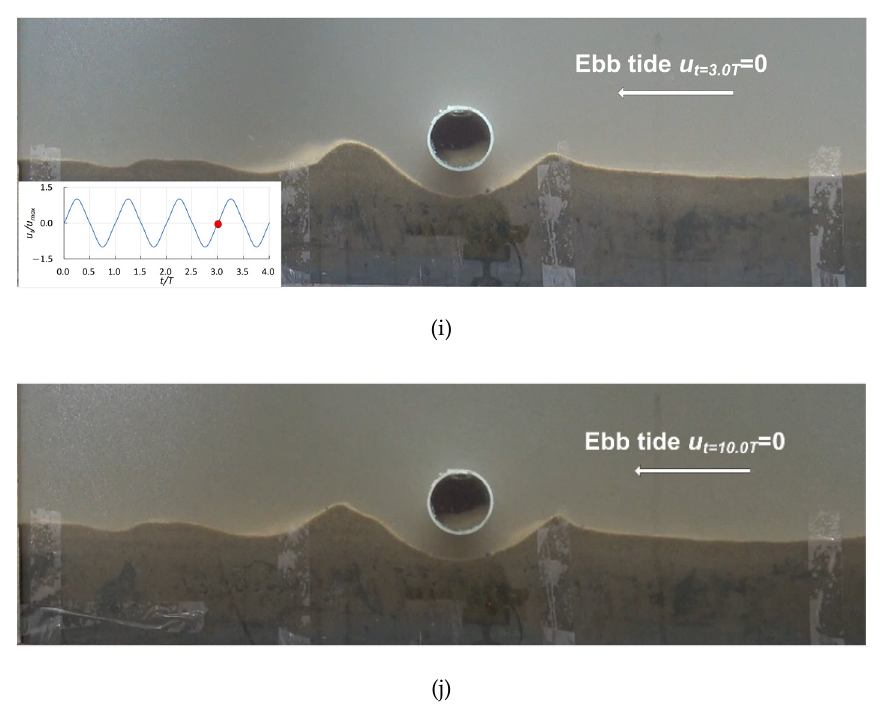
Figure 5. Time process of scour profile for Tide 01: u max = 0.3 m/s, D = 0.045 m. ( a ) t = 0.25 T ; ( b ) t = 0.50 T ; ( c ) t = 0.75 T ; ( d ) t = 1.0 T ; ( e ) t = 1.25 T ; ( f ) t = 1.50 T ; ( g ) t = 1.75 T ; ( h ) t = 2.0 T ; ( i ) t = 3.0 T ; ( j ) t = 10.0 T. J. Mar. Sci. Eng. 2021 , 9 , x FOR PEER REVIEW